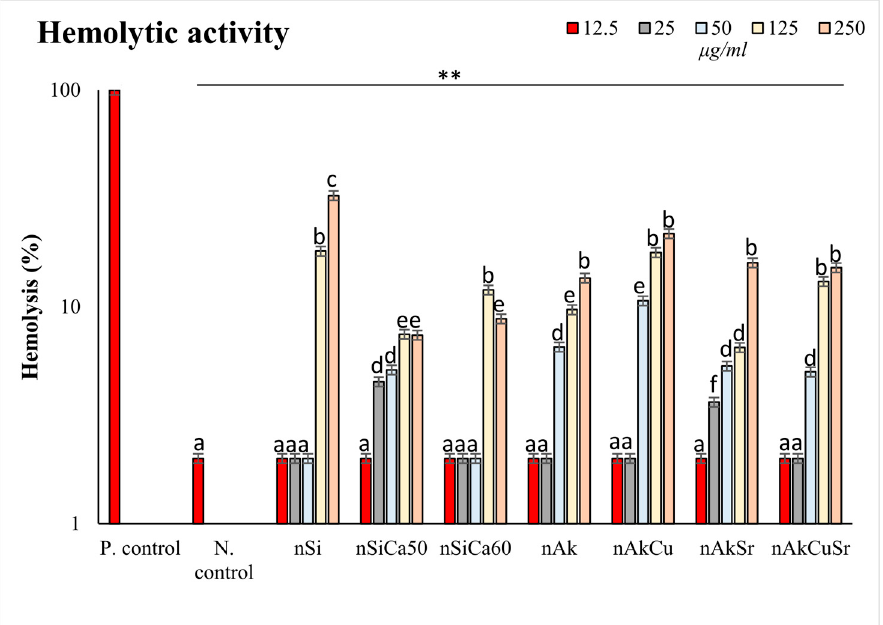
Figure 6 . Hemocompatibility of silica-based NPs at different concentrations (12.5, 25, 50, 125, and 250 μ g/mL) at body temperature (37 °C) after 24 h of incubation. ** indicates statistically significant differences ( p < 0.001) among negative control (N. control) and cells incubated with NPs, while different letters suggest statistically significant differences among concentrations.